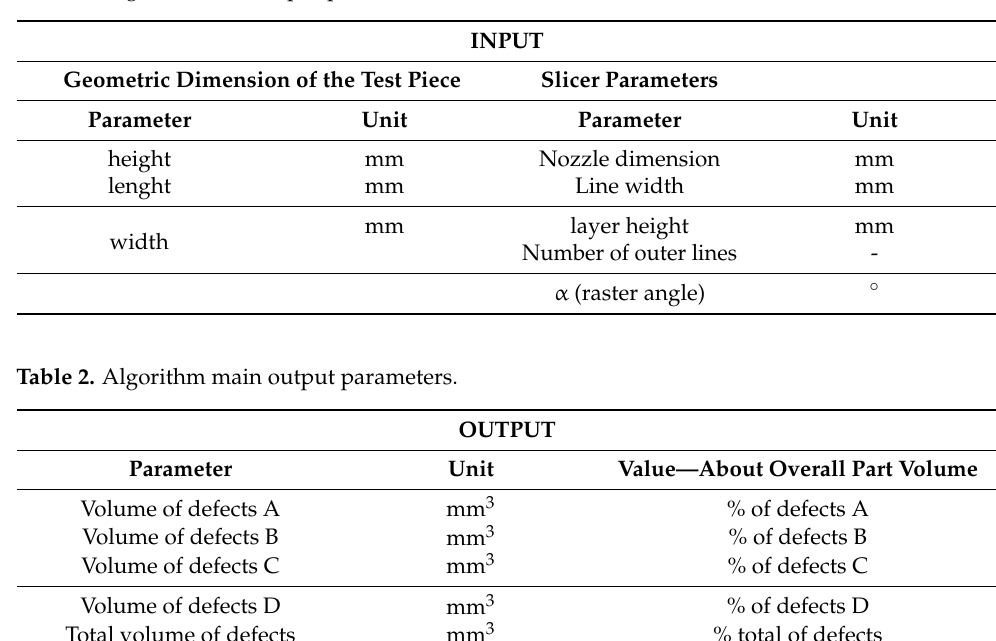
Table 1. Algorithm main input parameters.